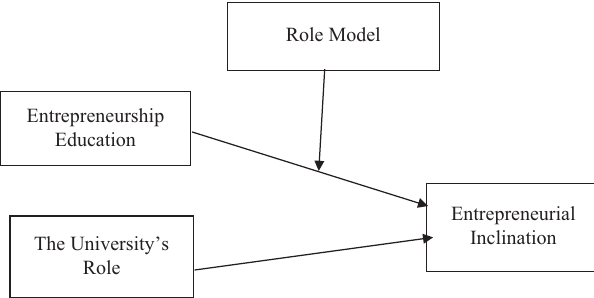
Figure 1. Conceptual model